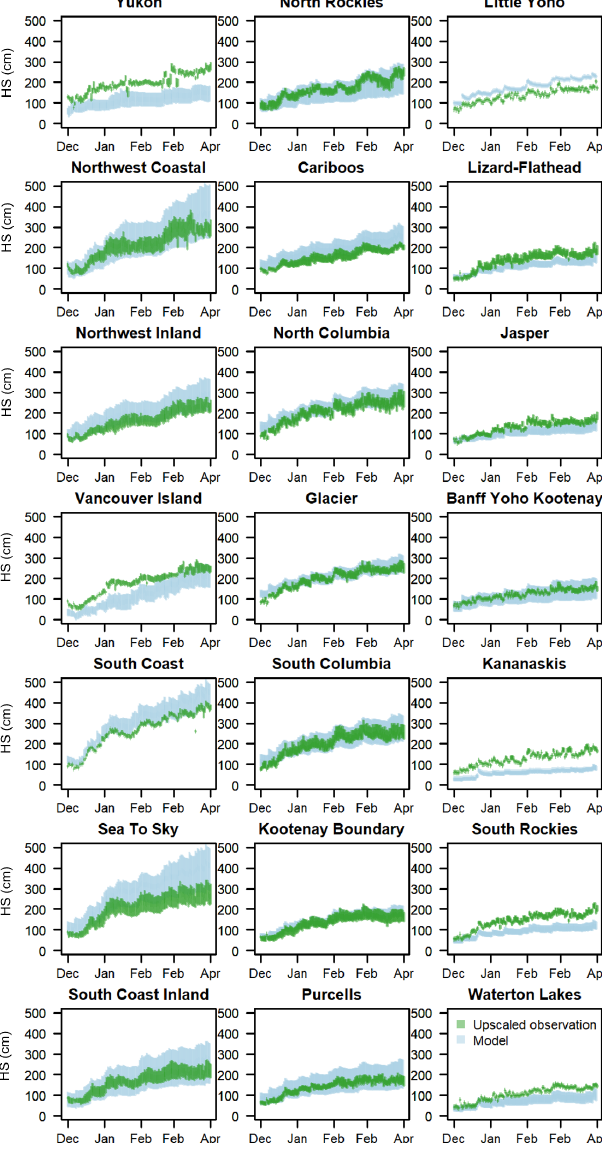
Figure 6. Interquartile range of snow depths for each avalanche forecast region throughout the study period from model (blue) and upscaled observation (green)